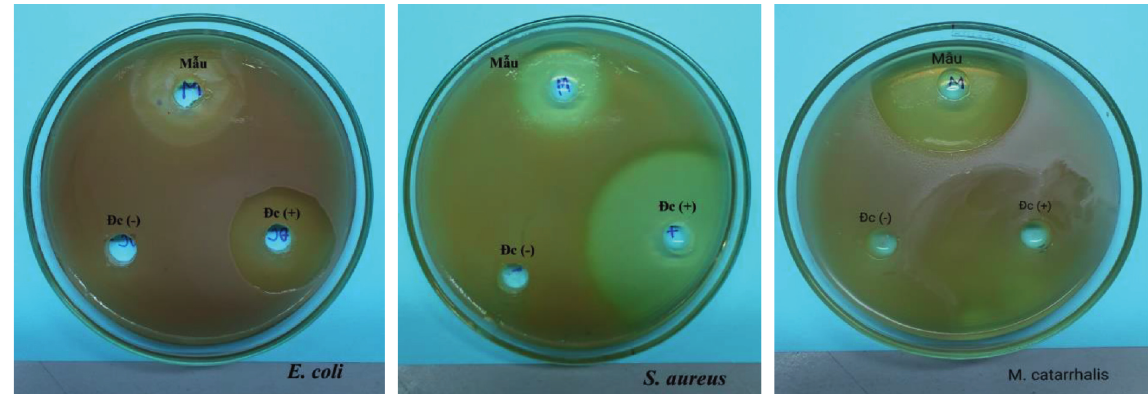
Figure 17: Result of testing antibacterial ability of chitosan suspension and nasal spray (5ml nasal spray and 5ml of chitosan suspension prepared at a concentration of 5